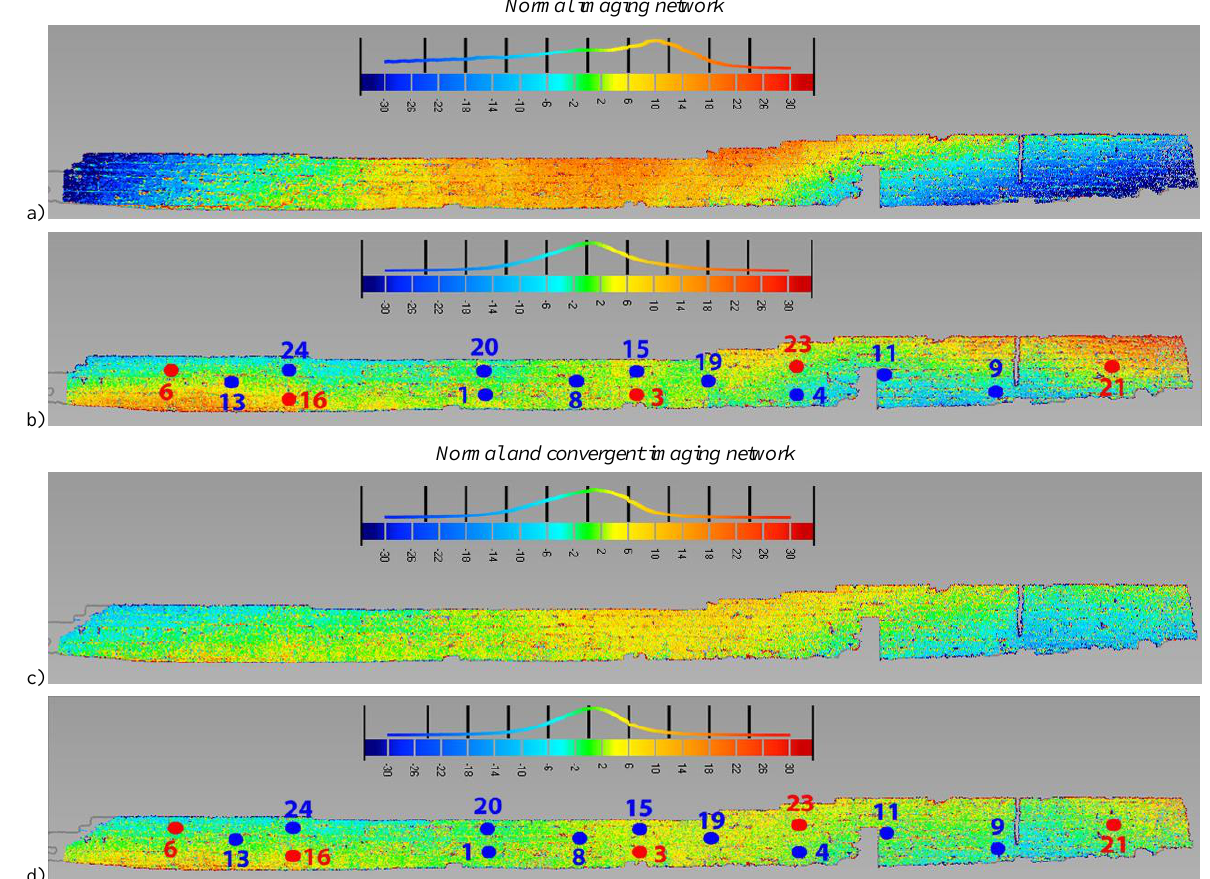
Figure 6: Euclidean distances between laser and photogrammetric data for the free network solutions (a, c) and constrained solutions (b, d). Version A is the most uncontrolled solution with the highest RMSEs for Z coordinates and the highest STDVs for the focal length. Version B shows that the inclusion of 5 well distributed GCPs can improve the accuracy of the bundle outcomes. The results of scenarios C and D show no statistically significant differences, suggesting that the block configuration is sufficiently strengthen by oblique images even without GCPs.